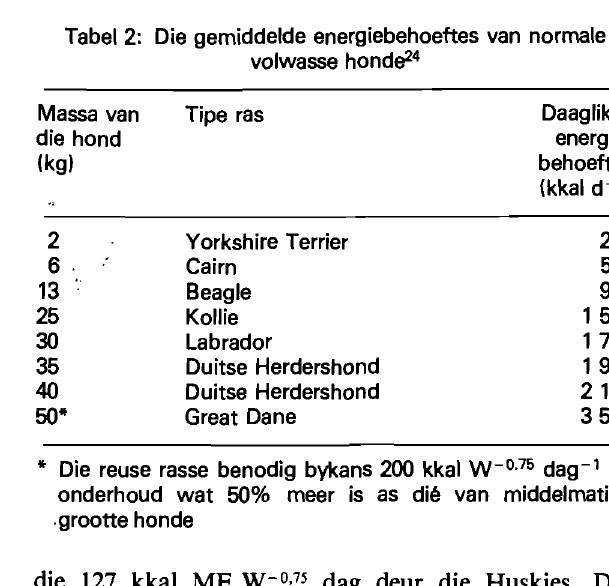
Tabel 2: Die gemiddelde energiebehoeftes van normale volwasse honde2 4 Massa